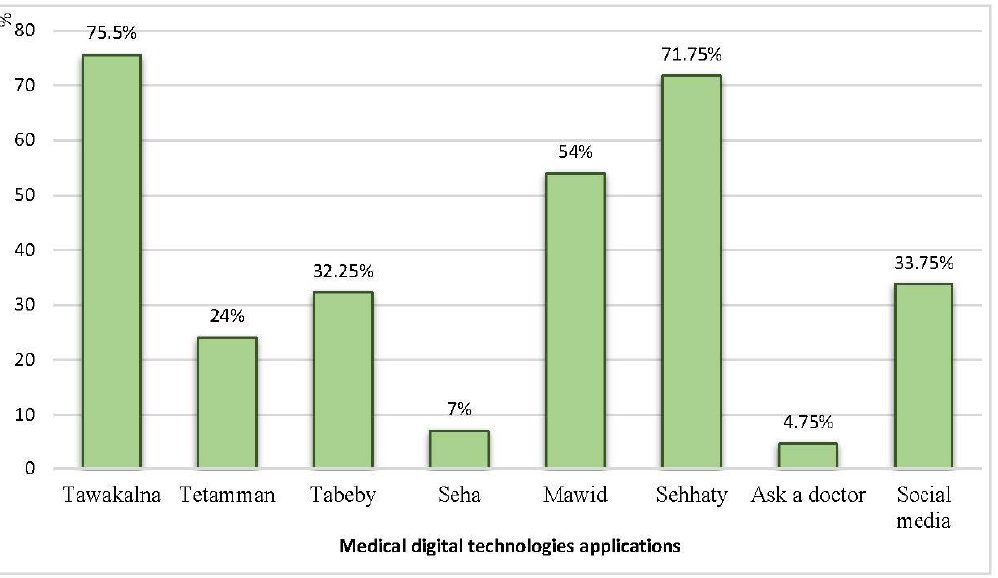
Figure 3. Percentage distribution of medical digital technology applications used by patients in this study during the COVID-19 pandemic.